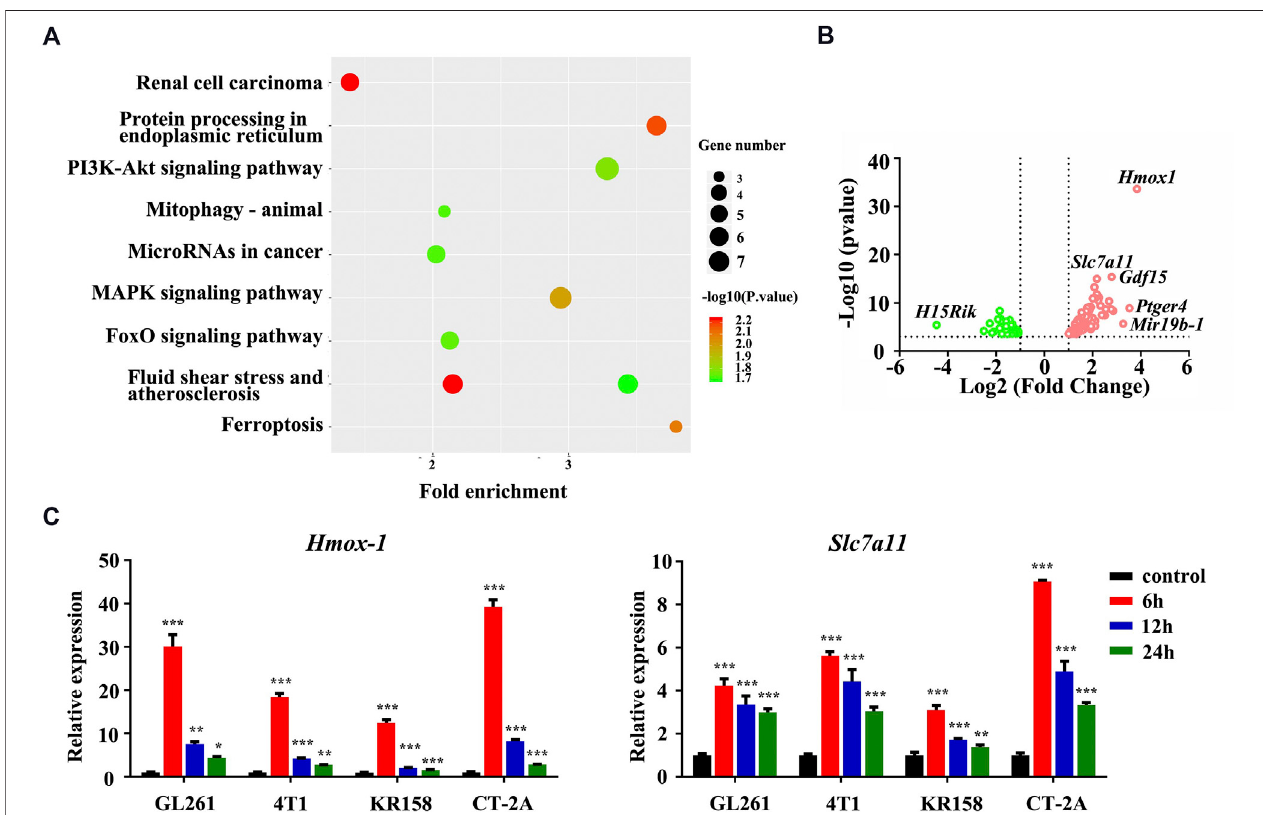
FIGURE1| The ferroptosis pathway wasinvolvedin4HC-treated tumor cells. (A) Dotplots showtheenriched termsidenti fi edintheKEGG analysisofdifferentially expressed genes detected in 4HC-treated GL261 cells compared with vehicle-treated cells, and the ferroptosis pathway was altered. (B) Volcano plot showing the upregulated and downregulated genes in response to 4HC treatment measured using RNA-seq. Solid symbols indicate genes in which the differential expression was statistically signi fi cant. Red, upregulated genes; green, downregulated genes. (C) Relative expression of the Hmox-1 and Slc7a11 mRNAs in different cell lines treated with 4HC (20 μ M) for 6, 12 and 24 h. Data are presented as the means ± SD from more than three independent experiments; * p < 0.05, ** p < 0.01, and **** p < 0.001 (one-way ANOVA analysis).